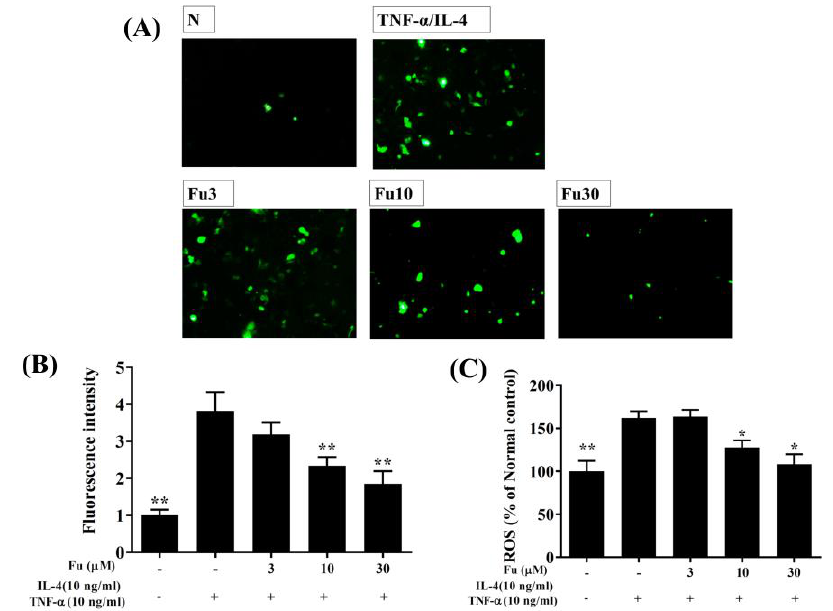
Figure 3. The effects of fucoxanthin (Fu) on ROS production in activated BEAS-2B cells. ( A ) Fluo- rescence microscopy images of intracellular ROS. ( B ) Fluorescence intensity of intracellular ROS. ( C ) Percentages of ROS detected in TNF- α /IL-4-activated BEAS-2B cells in the absence or presence of Fu compared to untreated cells (N). Three independent experiments were analyzed. Data are presented as mean ± SEM. * p < 0.05, ** p < 0.01 compared to BEAS-2B cells stimulated with TNF- α and IL-4.